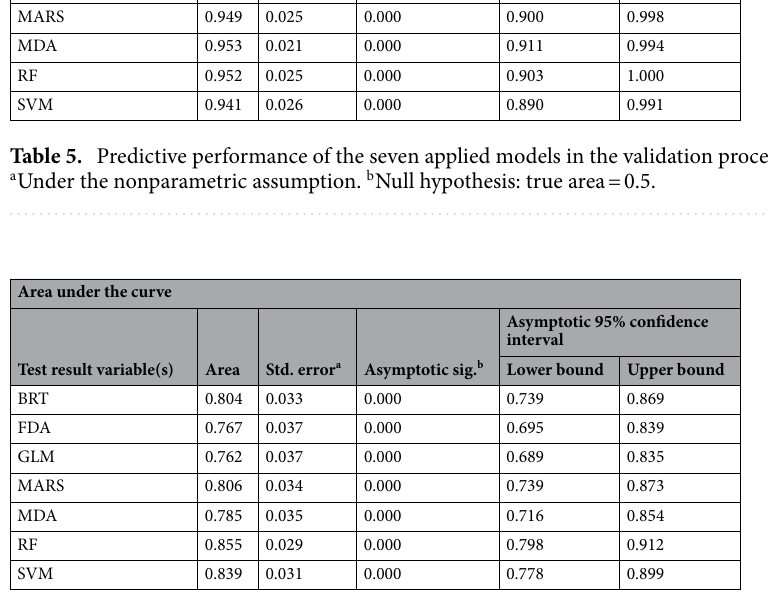
Table 6. Predictive performance of the seven applied models in the validation process of collapsed pipes 2020. a Under the nonparametric assumption. b Null hypothesis: true area = 0.5.